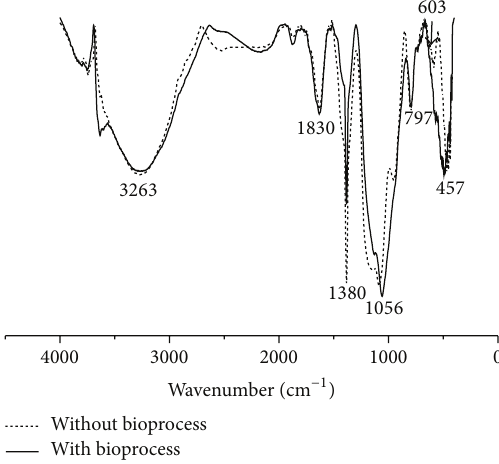
Figure 1: IR spectra of silica particles obtained for annelids bioprocess and without